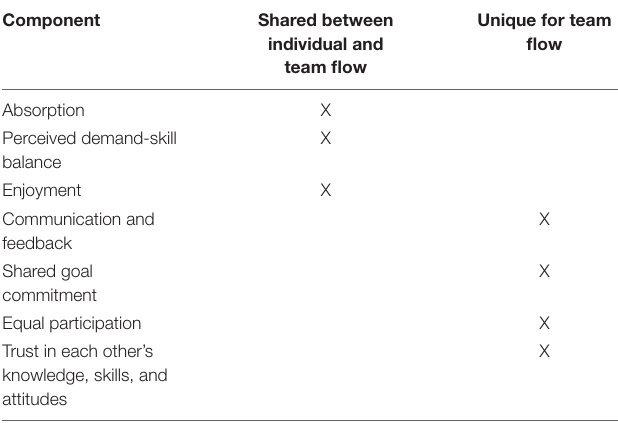
TABLE 2 | Components of team flow.